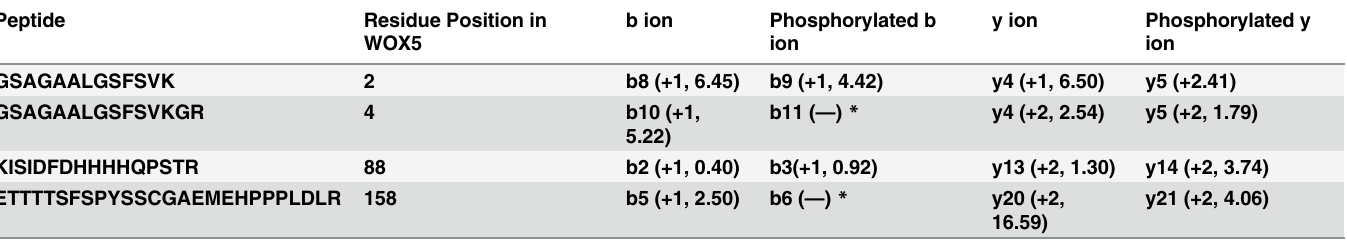
Table 1. Site-discriminating ions in WOX5 MS (the percentage of maximal intensity for each site-discriminating ion in the averaged low- resolution CID spectrum is shown in parenthesis.